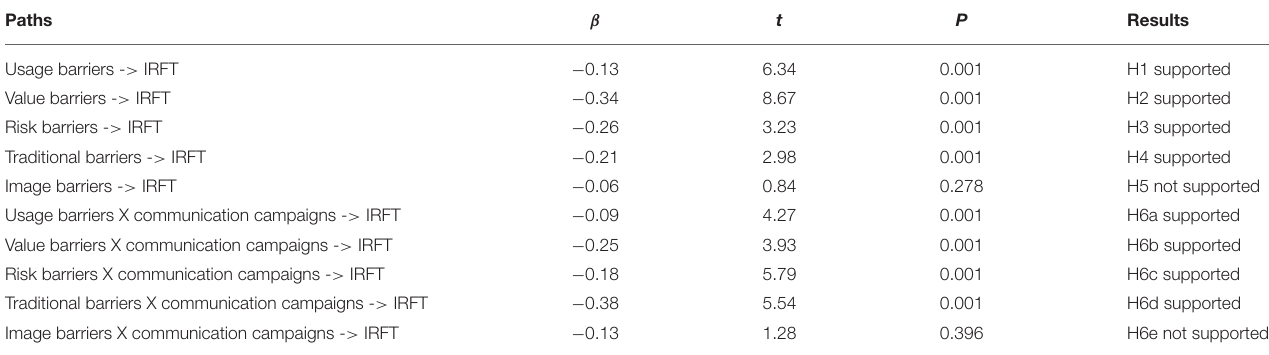
TABLE 4 | Standardized regression weights. Paths